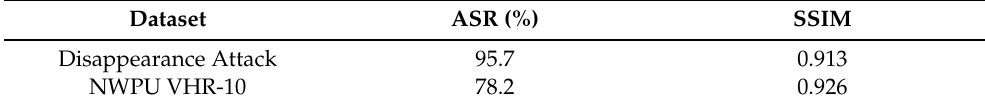
Table 1. The performance of our method in the digital